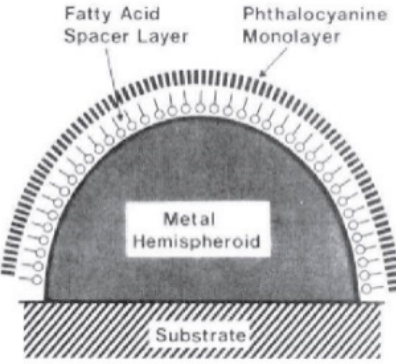
Figure 14. The metallic substrate is represented by the hemispheroid; on top of it, the arachidic acid layer (spacer) and the phthalocyanine (Raman probe). Reproduced with permission from Kovacs et al. [235]. Copyright (1986), American Chemical Society.